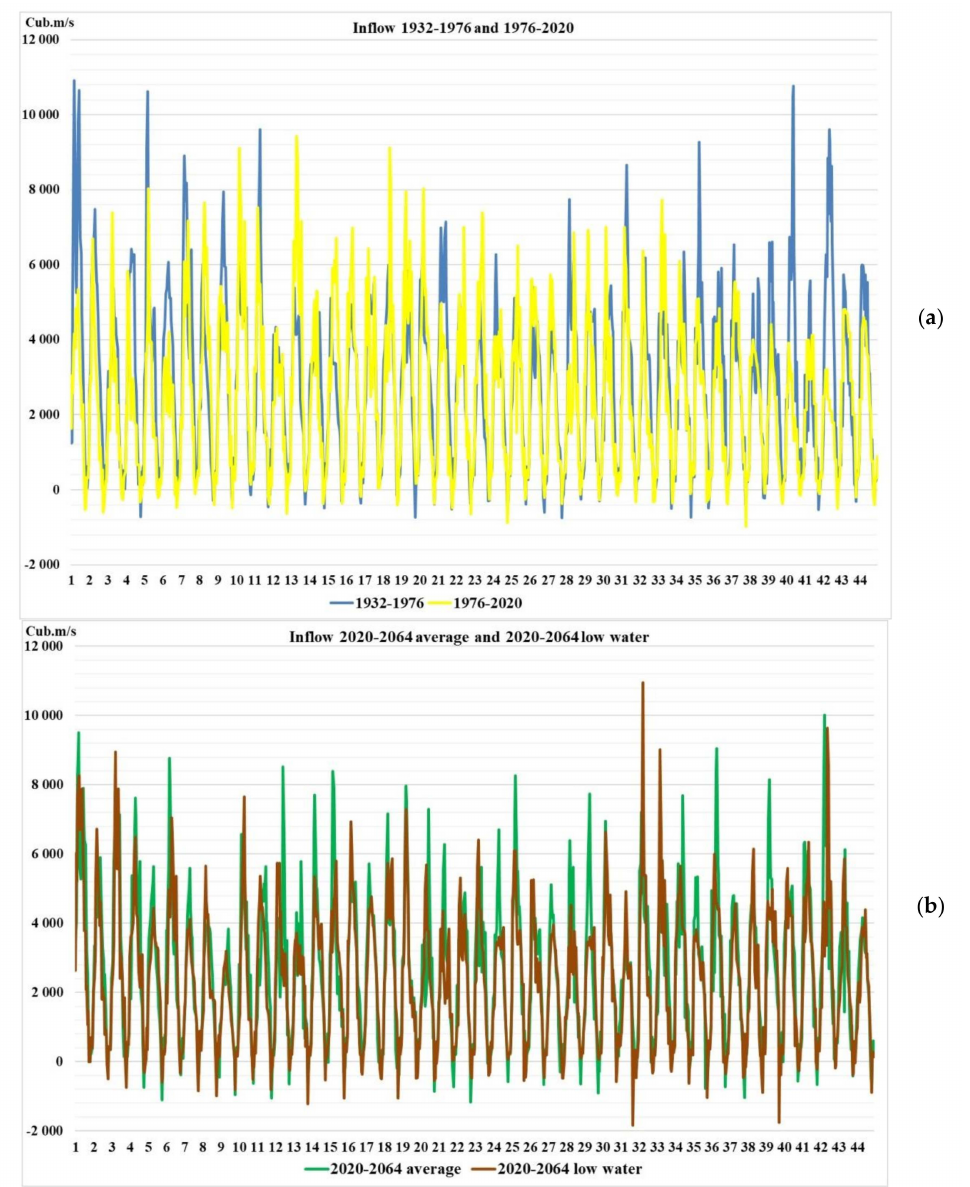
Figure 6. Long-term series of observed and forecast inflows. ( a ) 1932–1976 and 1976–2020; ( b )